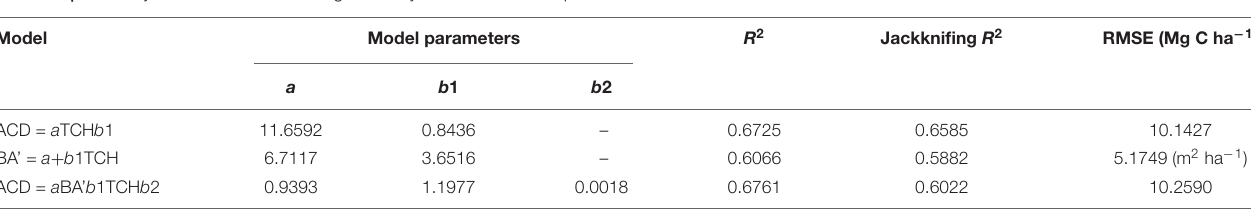
TABLE 3 | Summary for ACD estimation using TCH only or TCH and BA’ in pairs.